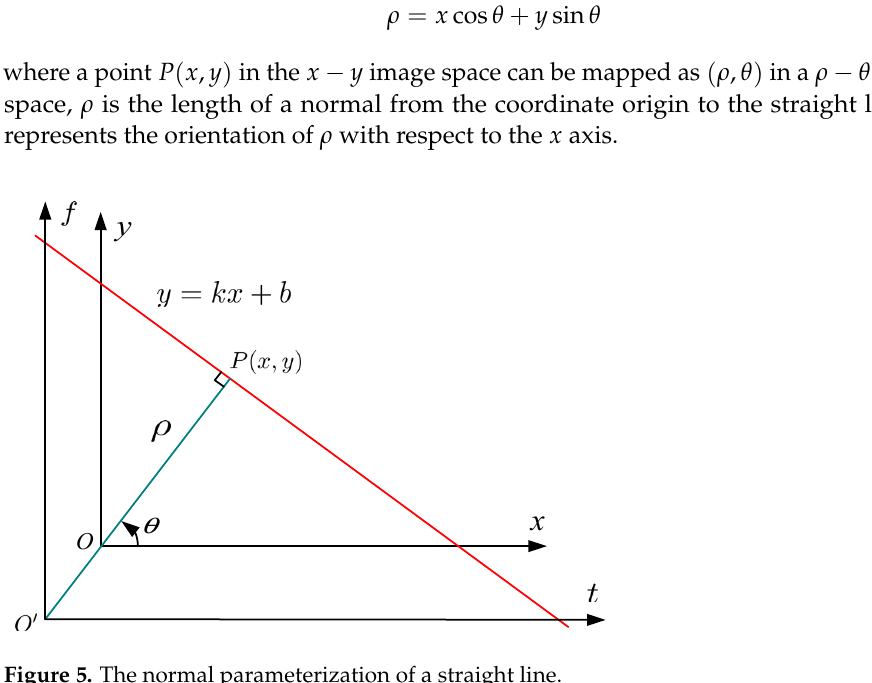
Figure 5. The normal parameterization of a straight line.